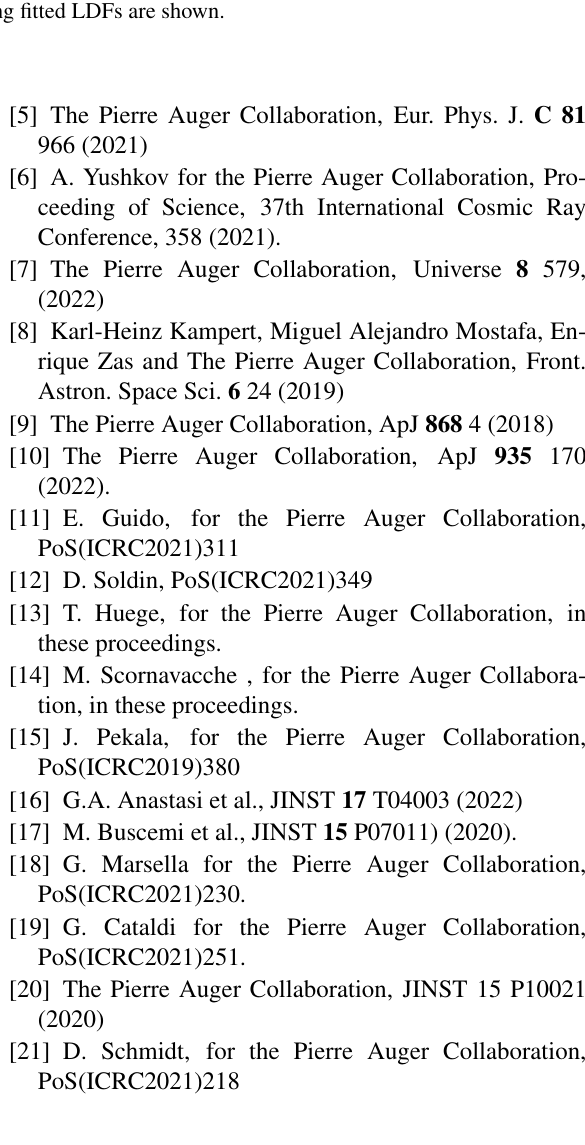
Figure 5. Exemple of a high-energy event measured in the pre-production array. The WCD (blue) and SSD (red) signal density are plotted as a function of the shower plane distance. Both corresponding fitted LDFs are